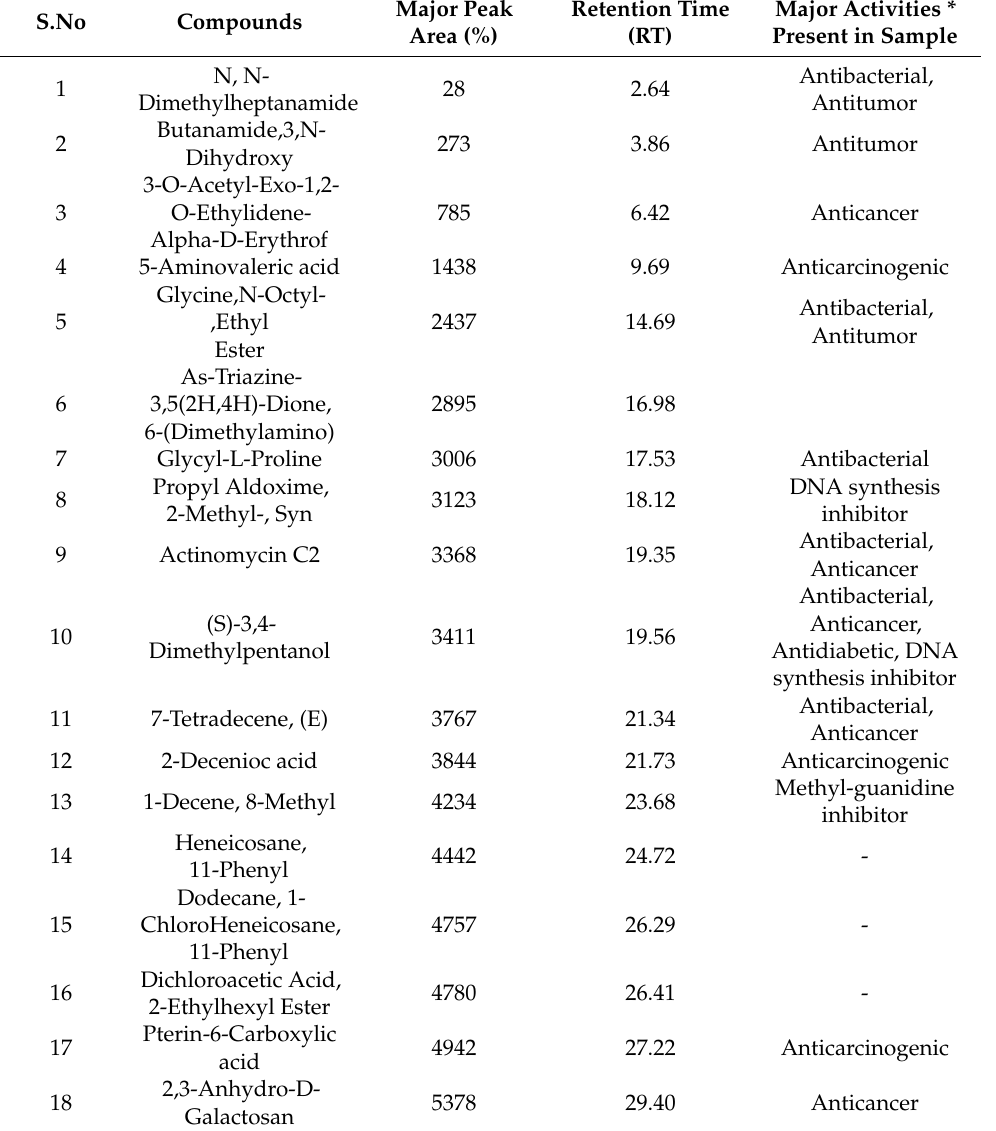
Table 4. Activity of bioactive compounds found in ethyl acetate extract of Beijerinickia fluminensis .